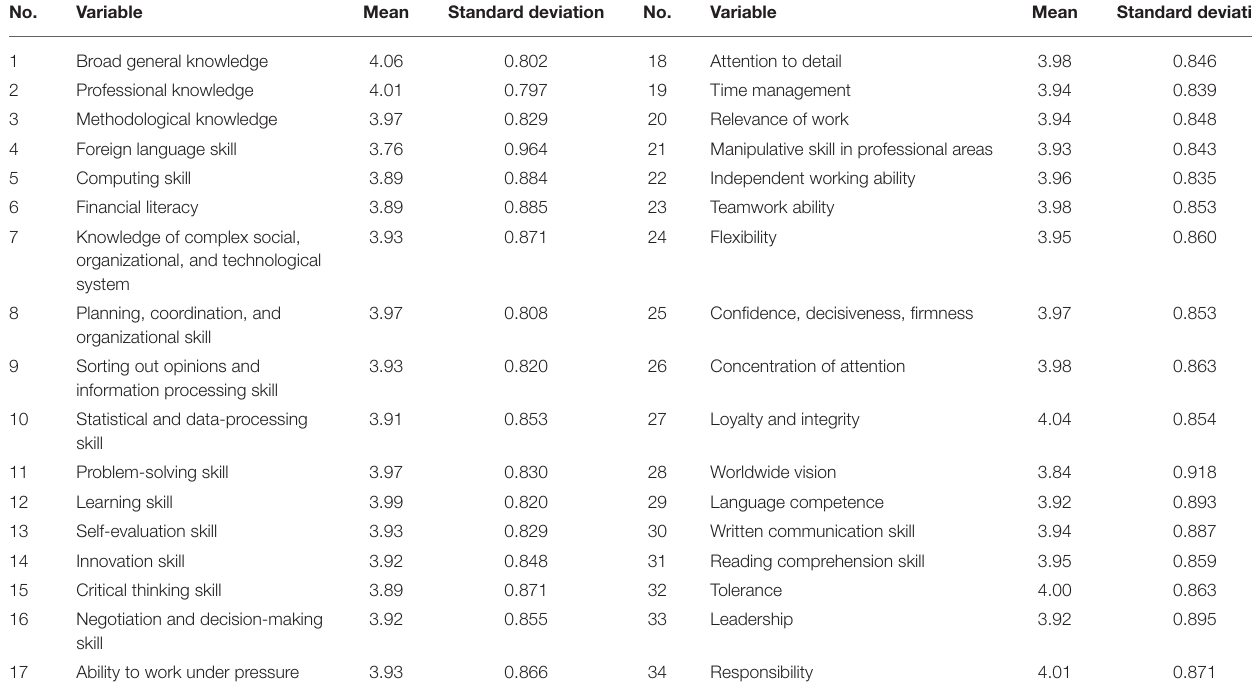
TABLE 1 | Descriptive statistical analysis of graduates’ ability